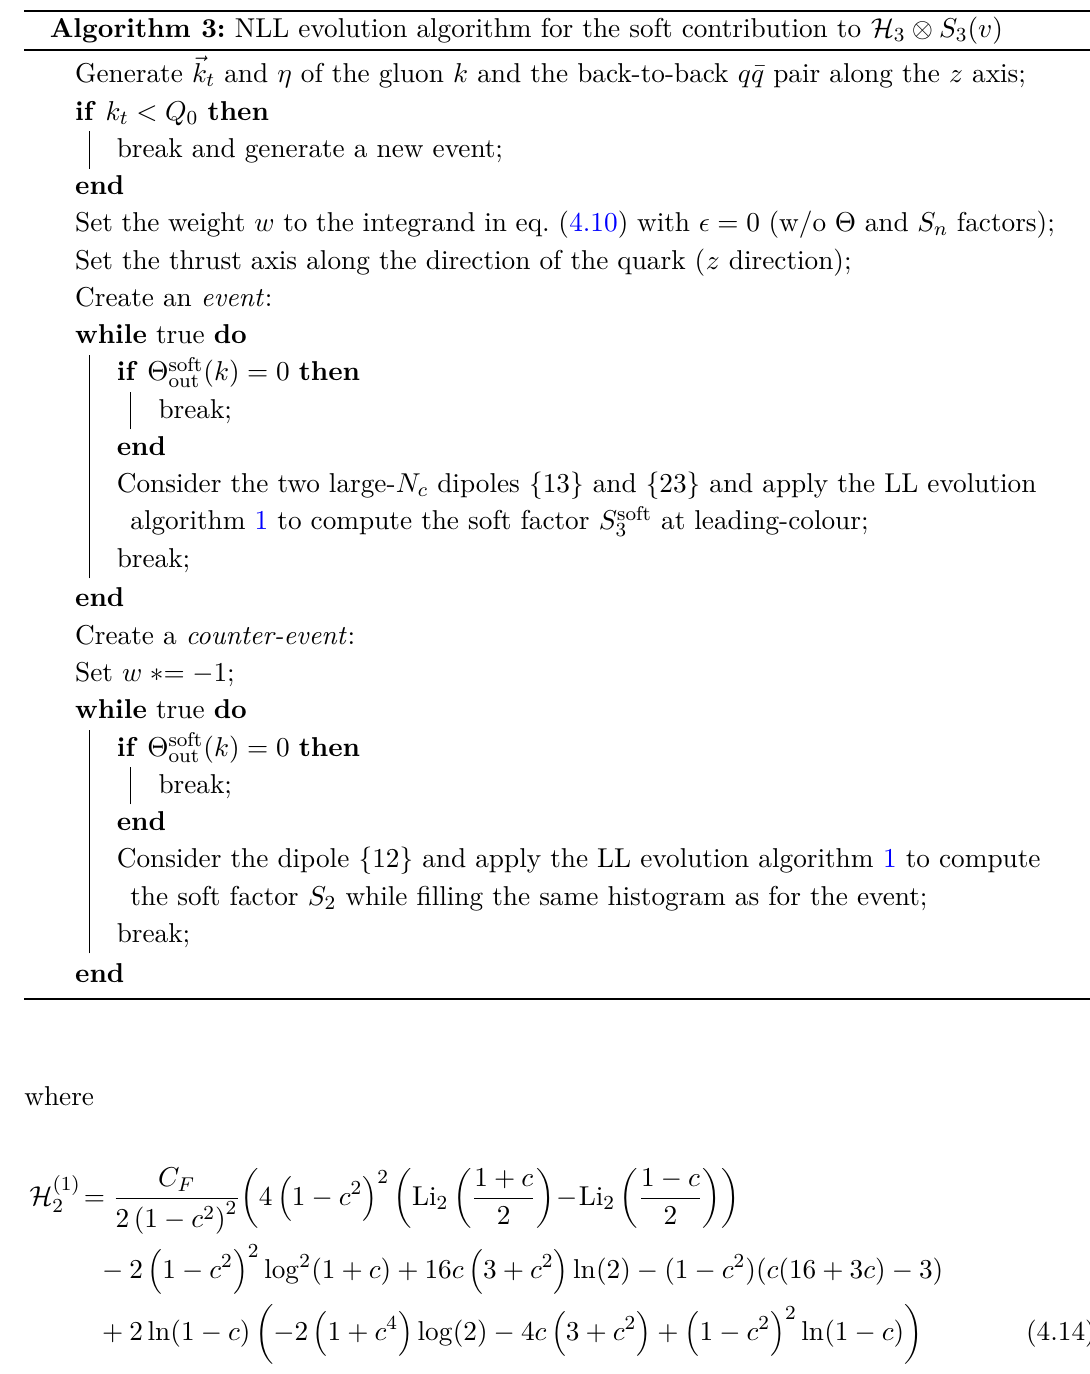
Algorithm 3: NLL evolution algorithm for the soft contribution to H